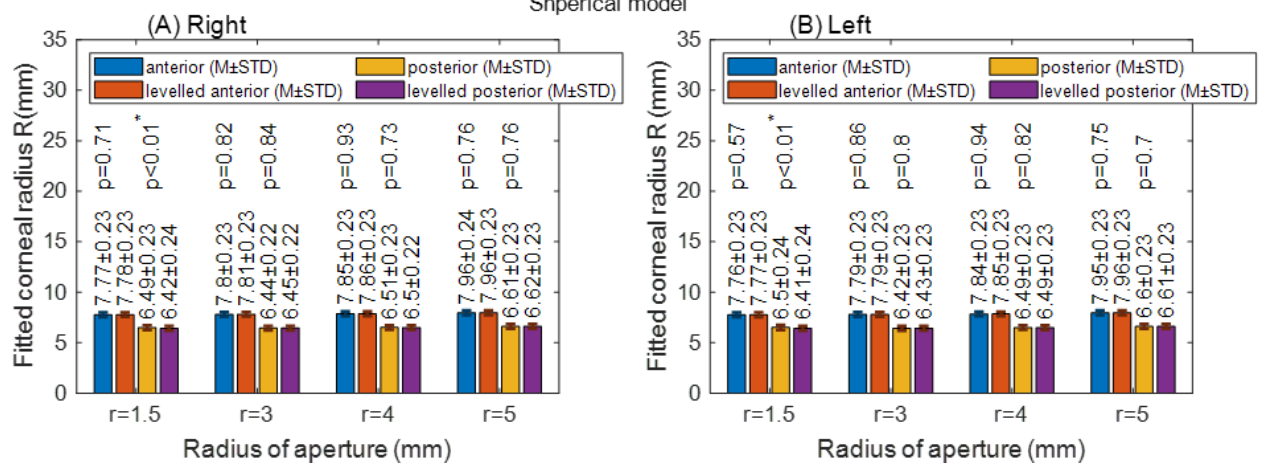
Figure 5. Corneal apical radius (R) fitted to spherical model with different radii of aperture (r). The asterisk (*) indicates the statical significance ( A ) Right corneas; ( B ) Left corneas.